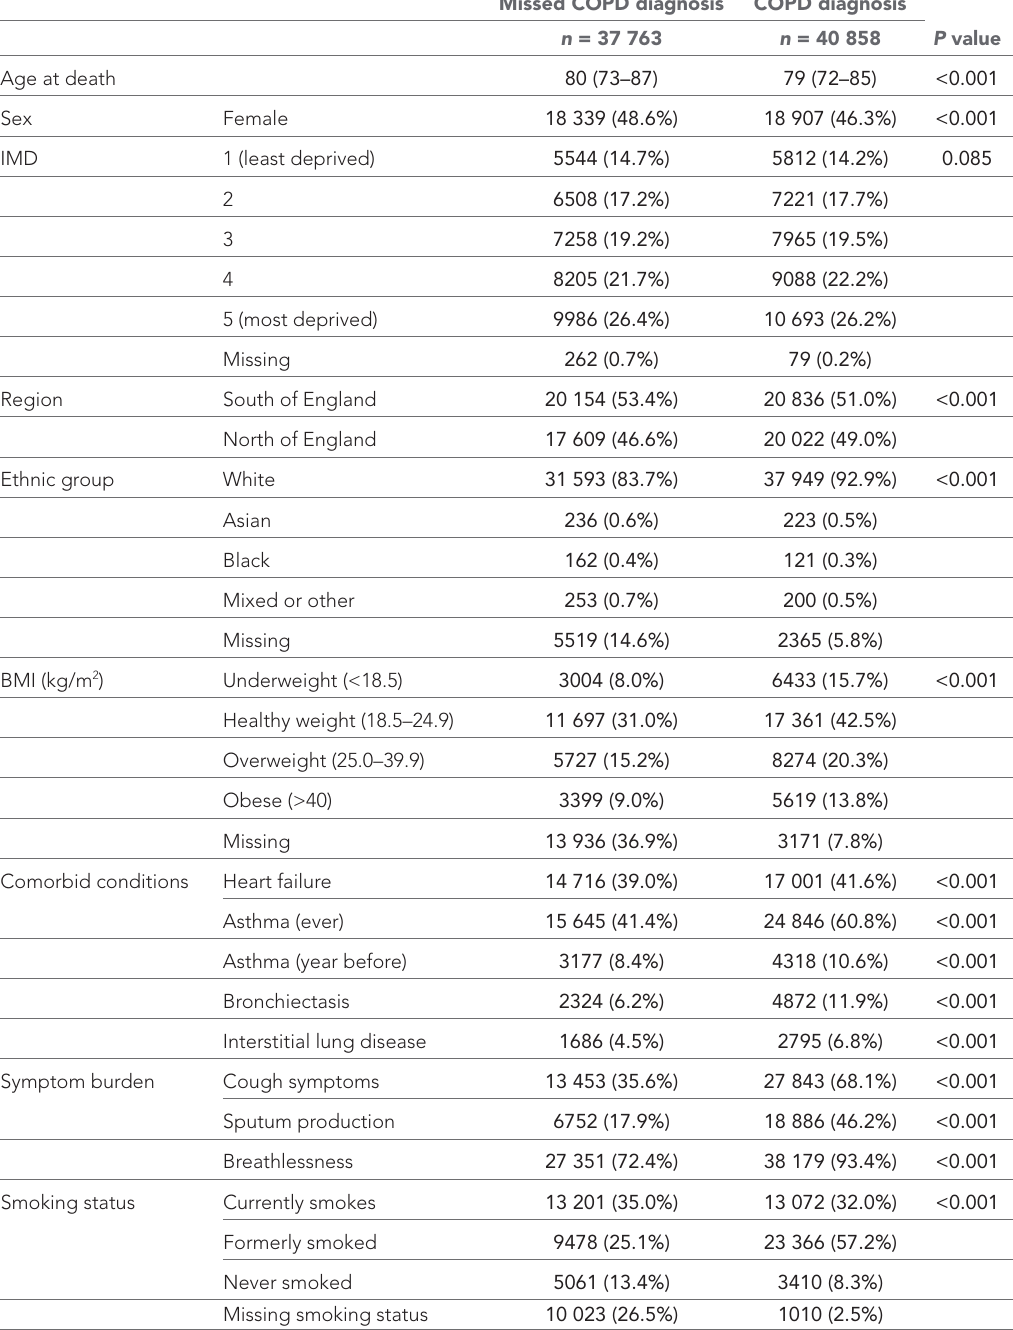
BMI = body mass index. COPD = chronic obstructive pulmonary disease. IMD = Index of Multiple Deprivation. Data are presented as n (%) for categorical measures, and median and interquartile range for numerical variables. Comorbidities assessed as occurring at any point in medical record before